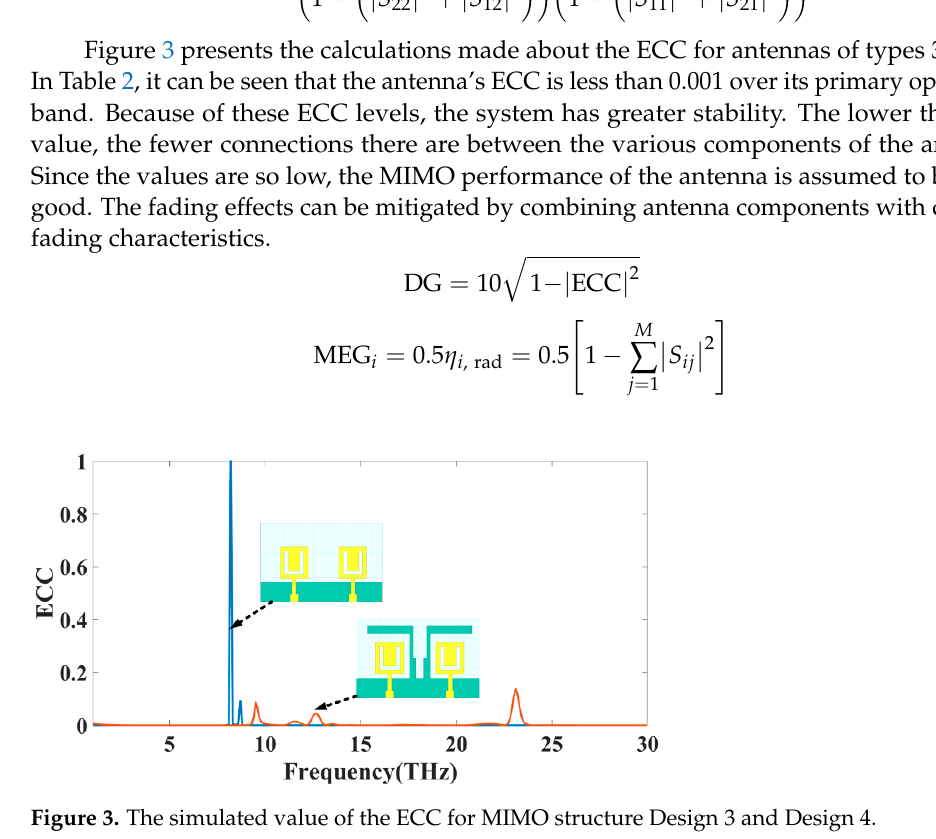
Figure 4. The DG (dB) simulated value for MIMO structure Design 3 and Design 4. According to the MEG parameter, the sum of the average power received by two isotropic antennas when there is no background noise is equal to or less than the average power received by a diversity antenna when noise is present (or interference). It shows